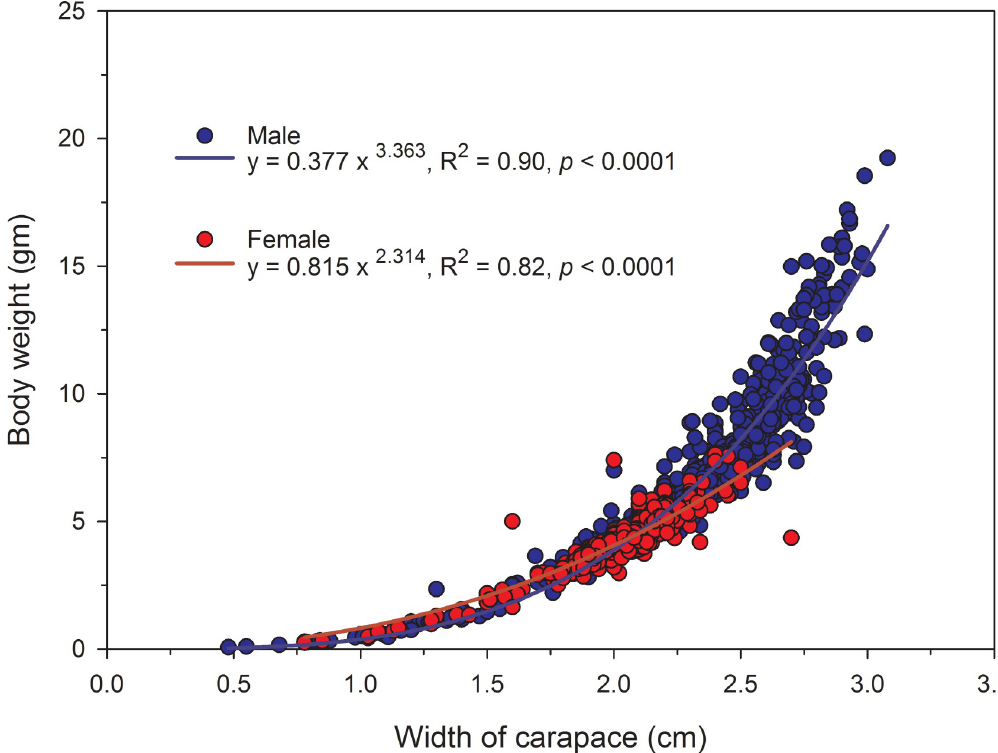
Fig 8. Relationship between the carapace width and wet weight of male and female Xenograpsus testudinatus collected from the hydrothermal vent area in Kueishan Island.